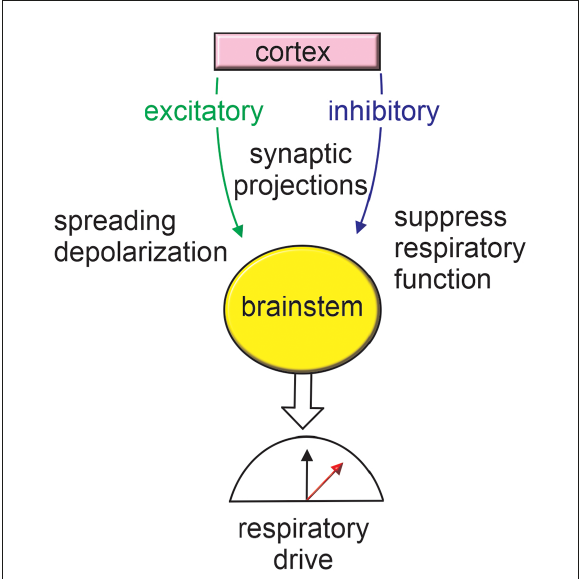
FIGURE2 Cortex-brainstem connections provide a framework for seizure- induced respiratory failure. Seizure activation of inhibitory cortical projections to brainstem respiratory centers has been shown to result in respiratory arrest. Seizure activity may also stimulate excitatory brainstem projections thereby resulting in metabolic stress and favoring the propagation of spreading depolarization.Formoreinformationonanatomicalregionsrefer to Figure 1